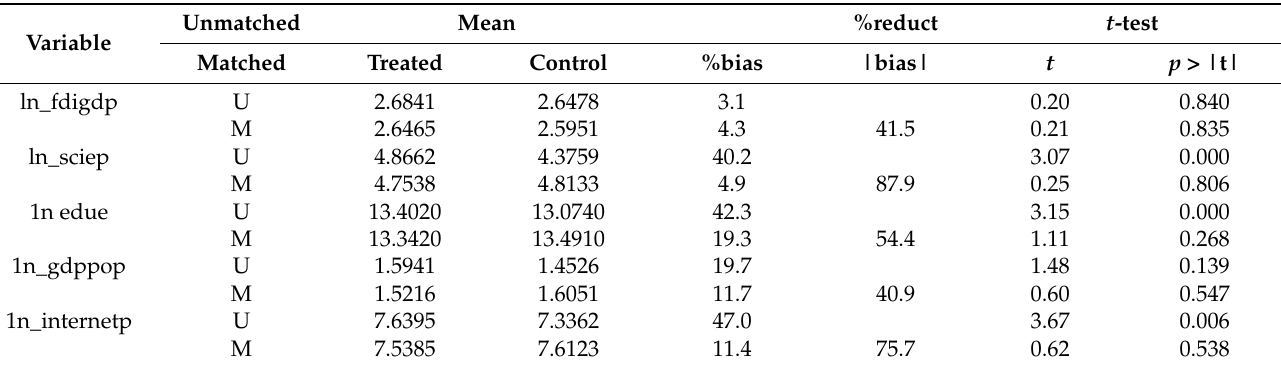
Table 4. Deviation and confidence level before and after PSM